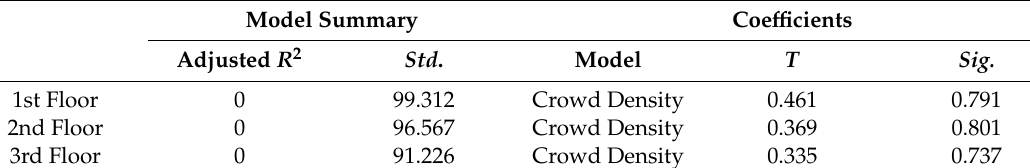
Table 3. Correlation analysis between the crowd density and error outside the store.